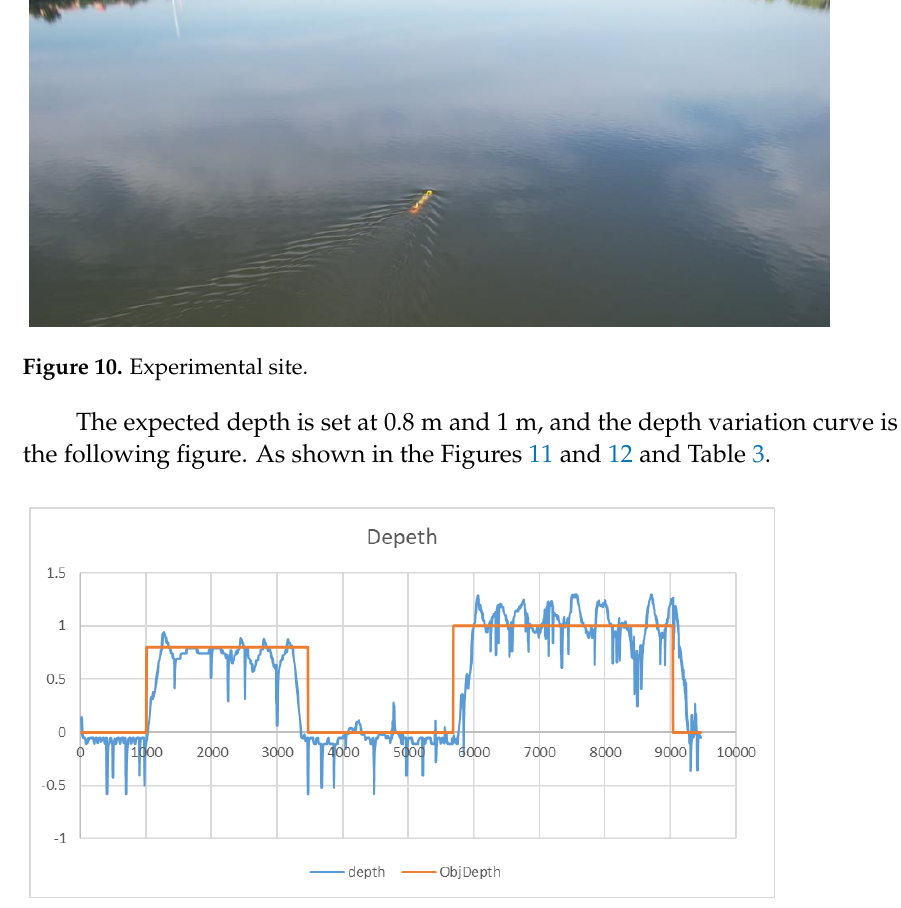
Figure 10. Experimental site.